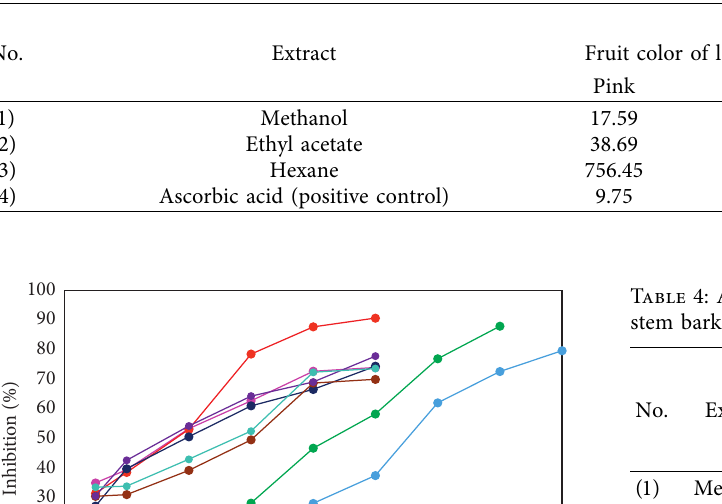
50 ) of S. aqueum leaves and stem bark extracts to DPPH free radicals.